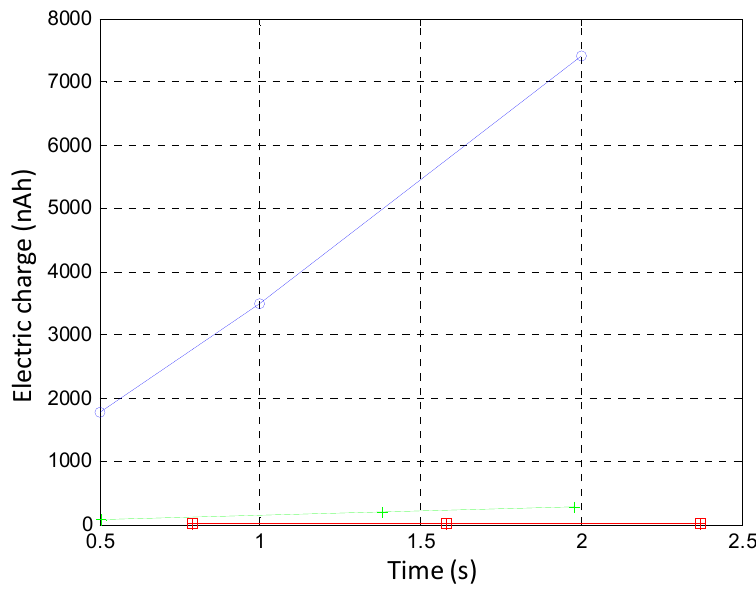
Figure 9. Charge drained from battery over time (blue, STD; green, LP; red, XLP).